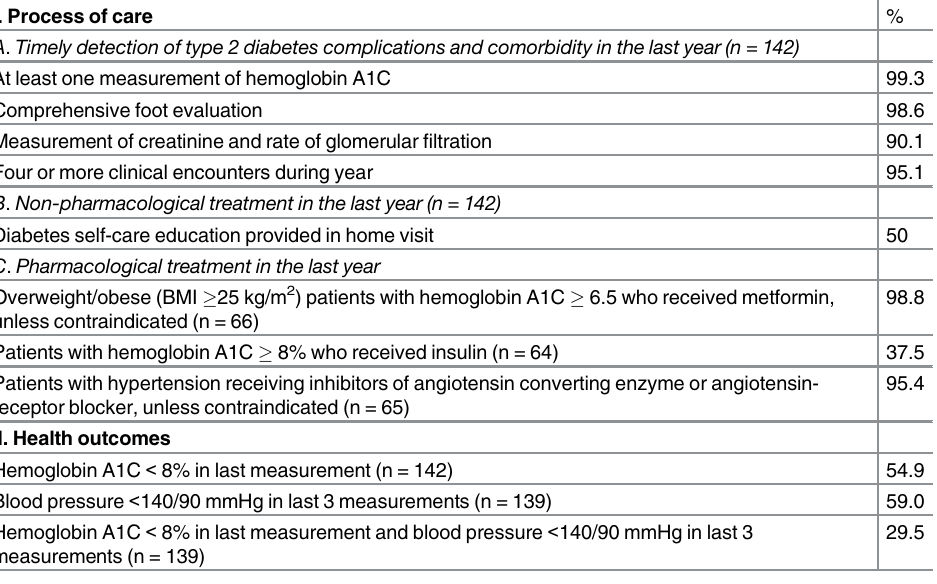
Table 4. Cross-sectional outcomes indicators for Type 2 Diabetes Cohort. I. Process of